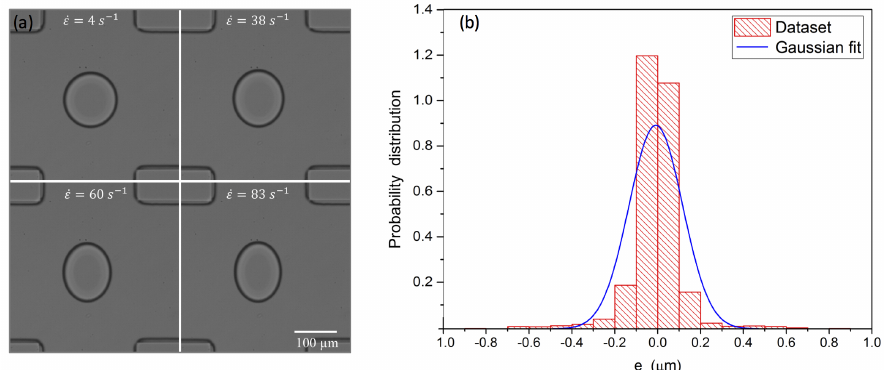
Figure 3. ( a ) Droplet deformation under different strain rates in a microchannel with channel height h = 80 µ m, ( b ) probability distribution of the droplet position at strain rate ˙ ε = 83 s − 1